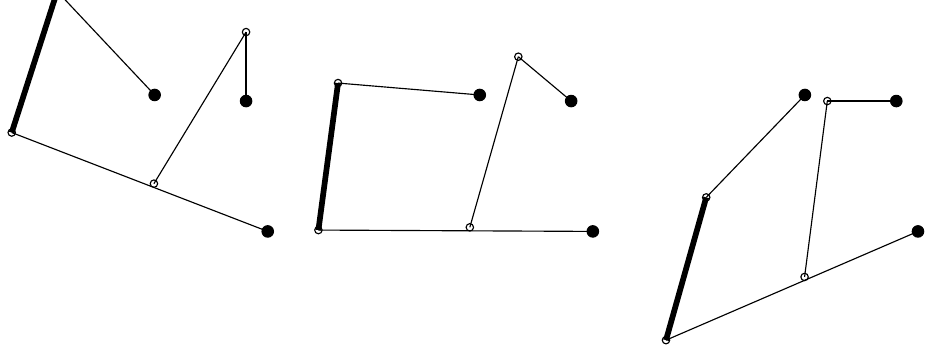
Figure 3. Three configurations of the linkage. ( Left ) α 3 = 90 ◦ . ( Middle ) α 3 = 140 ◦ . ( Right ) α 3 = 180 ◦ .